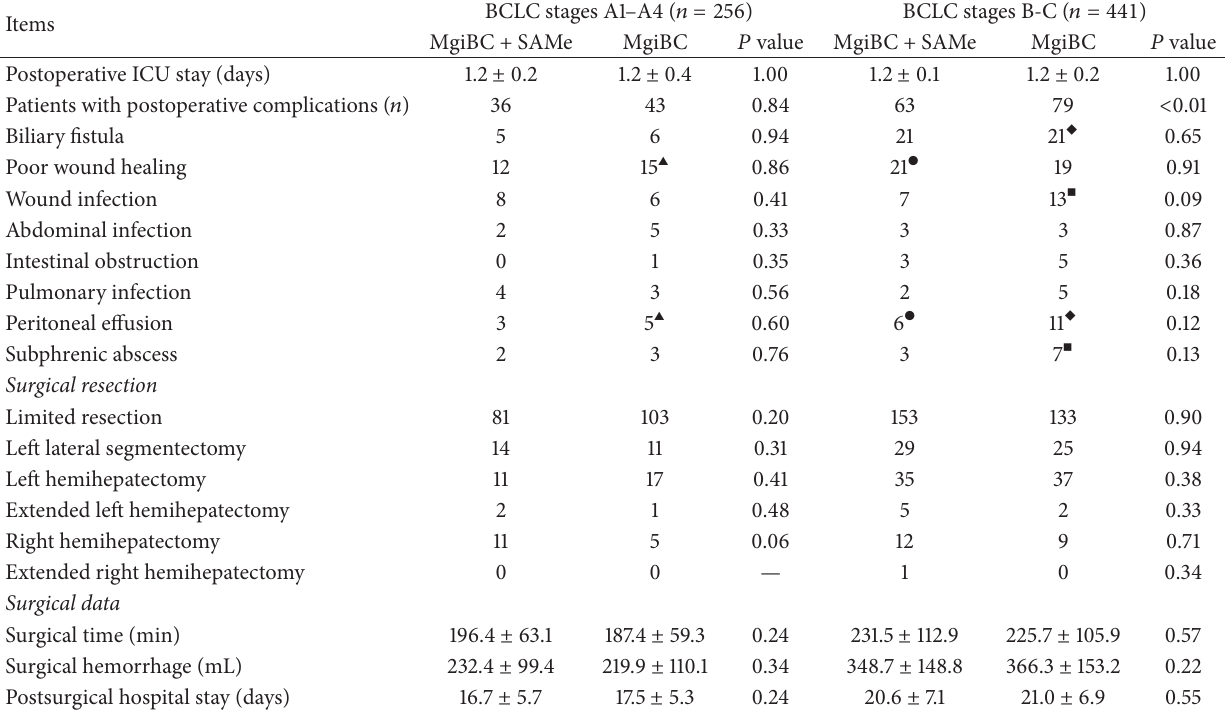
Table 2: Clinical characteristics of the included patients after